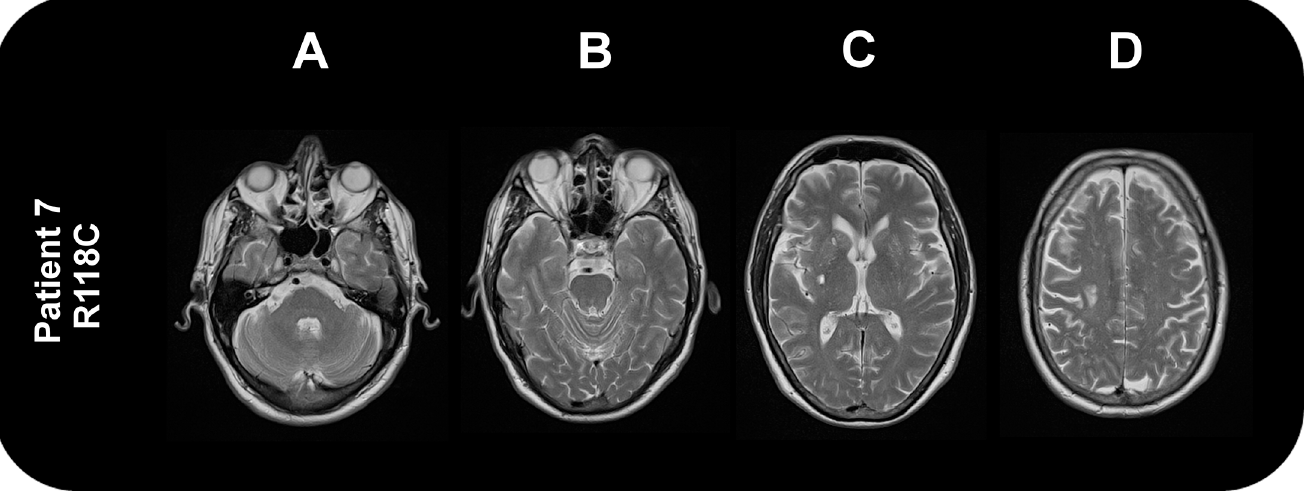
Fig 2. Brain MRI (T2-Weighted) of the patient carrying the GLA mutation R118C. Two lacunes are present in the right caudate nucleus and external capsule (C). An area of white matter hyperintensity is present in the peripheral right posterior frontal white matter (D). There were no abnormalities in the posterior